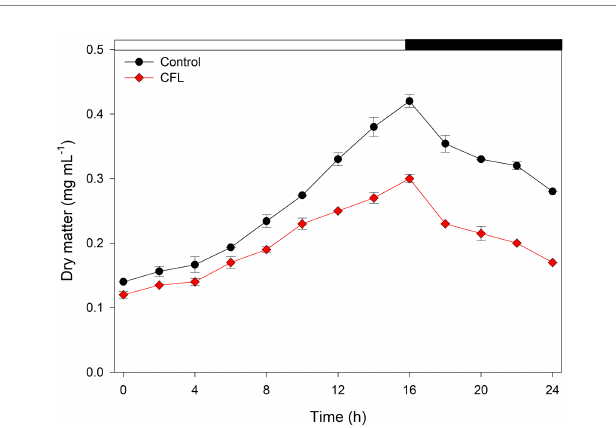
FIGURE 1 Growth of synchronous culture of Galdieria sulphuraria in control (black circles) and CFL–treated (red diamonds) medium, at pH 3, a light intensity of 350 μ mol photons m − 2 s − 1 and a temperature of 40 ° C, expressed as dry matter (DM) in μ g mL − 1 . The dark phase is indicated by the black bar above the graph. The data are plotted as means of biological triplicates. The error bars represent standard deviations (±SD) and are shown when larger than the symbol